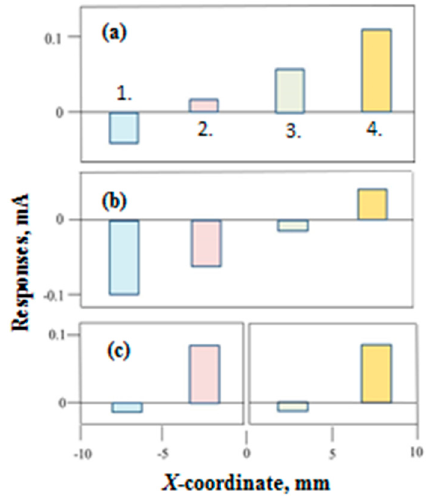
Figure 4. Evidence for an indivisible behavior of (H) the system under study. ( a ) Local responses at B = 5 T; ( b ) Local responses after reversing the magnetic field; ( c ) Local responses after splitting the sample.